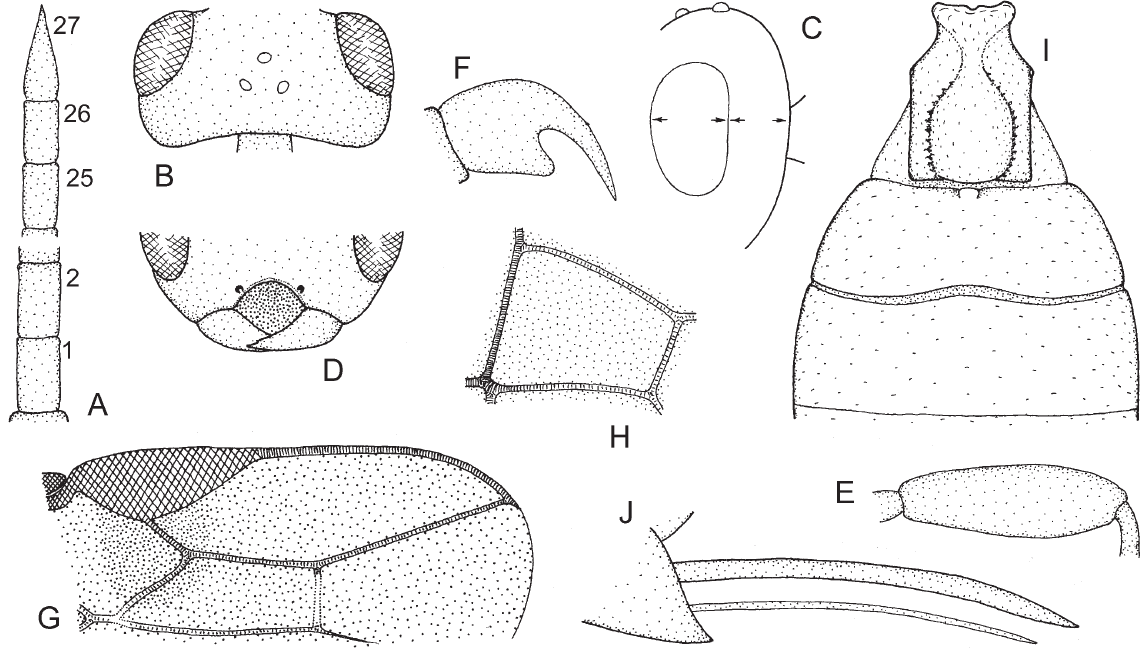
Fig. 67. Bracon ( Glabrobracon ) variator Nees, 1811, ♀ neotype. A . flagellomeres 1-2 and 25-27. B . Head in dorsal view. C . Head in lateral view. D . Head in frontal view. E . Hind femur. F . Claw. G . Distal part of right forewing. H . First discal cell of right forewing. I . Tergites 1-3. J . Hypopygium and ovipositor